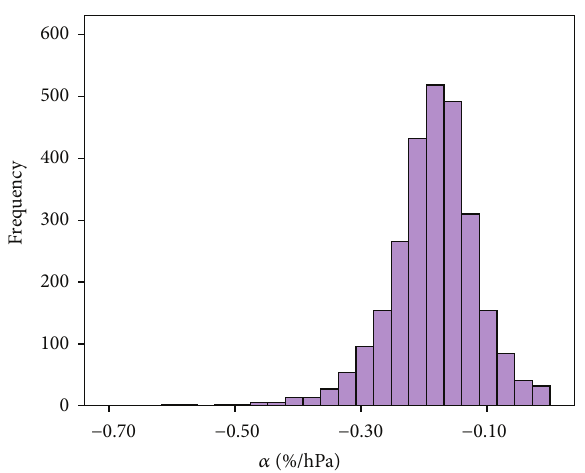
Figure 2: The frequency distribution of the calculated daily values of the barometric coefficients, 𝛼 , for 2717 days.